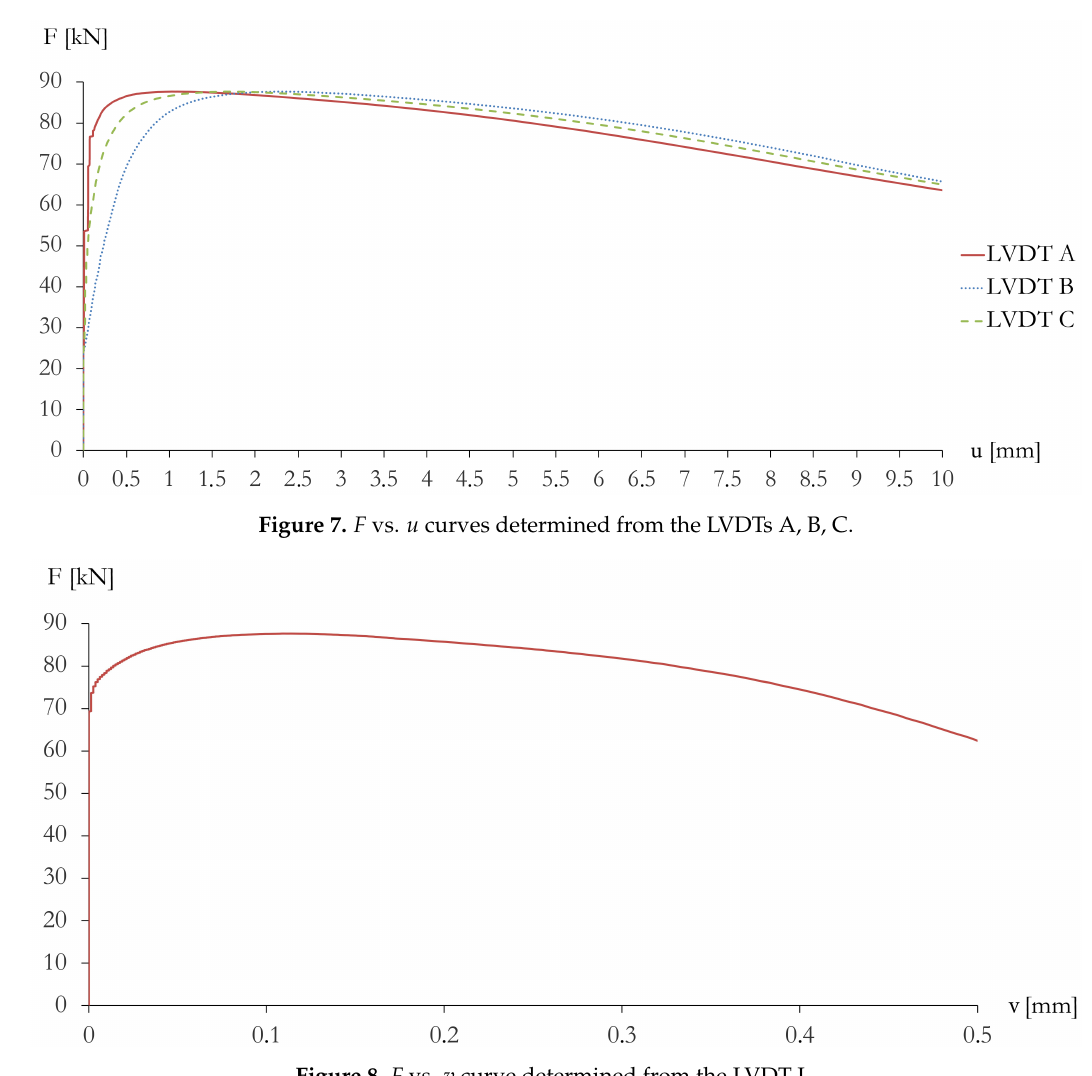
Figure 6. F vs. w curve determined from testing machine.